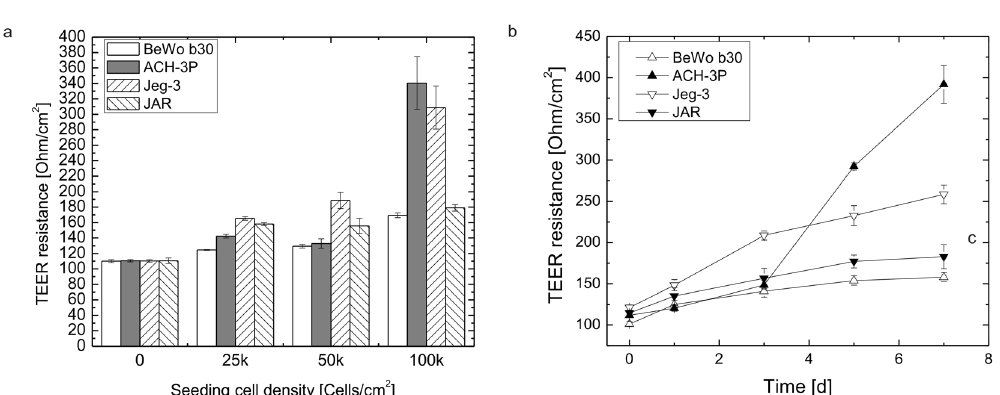
Figure 2. Barrier integrity of trophoblast cell lines based on trans-epithelial electrical resistance (TEER). ( a ) Influence of initial seeding density of BeWo b30, ACH-3P, Jeg-3 and JAR placental cells on electrical resistance on day 5 post-seeding. ( b ) Increase of electrical resistance of BeWo b30, ACH-3P, Jeg-3 and JAR placental cell barriers on day 1, 3, 5 and 7 post-seeding. Data points are presented as mean values ± SD for n = 6 and expressed as absolute values. Values on day 0 correspond to blank membrane values of acellular